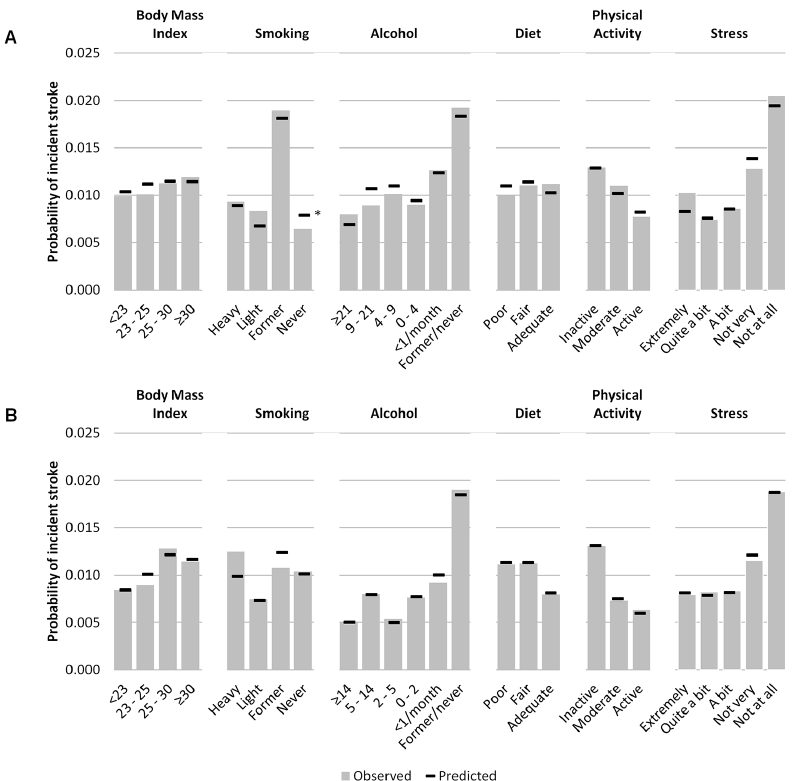
Fig 3. Observed versus predicted risk of 5-year incident stoke by health behaviour, BMI, and stress. Panel A = males; Panel B = females.